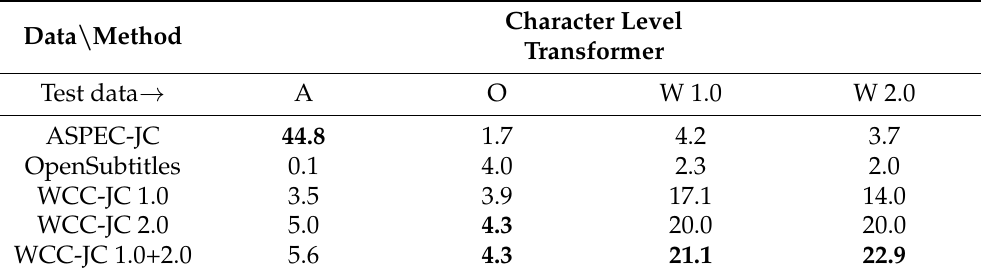
Table 9. Results of Chinese → Japanese translation experiments at character level (BLEU scores).